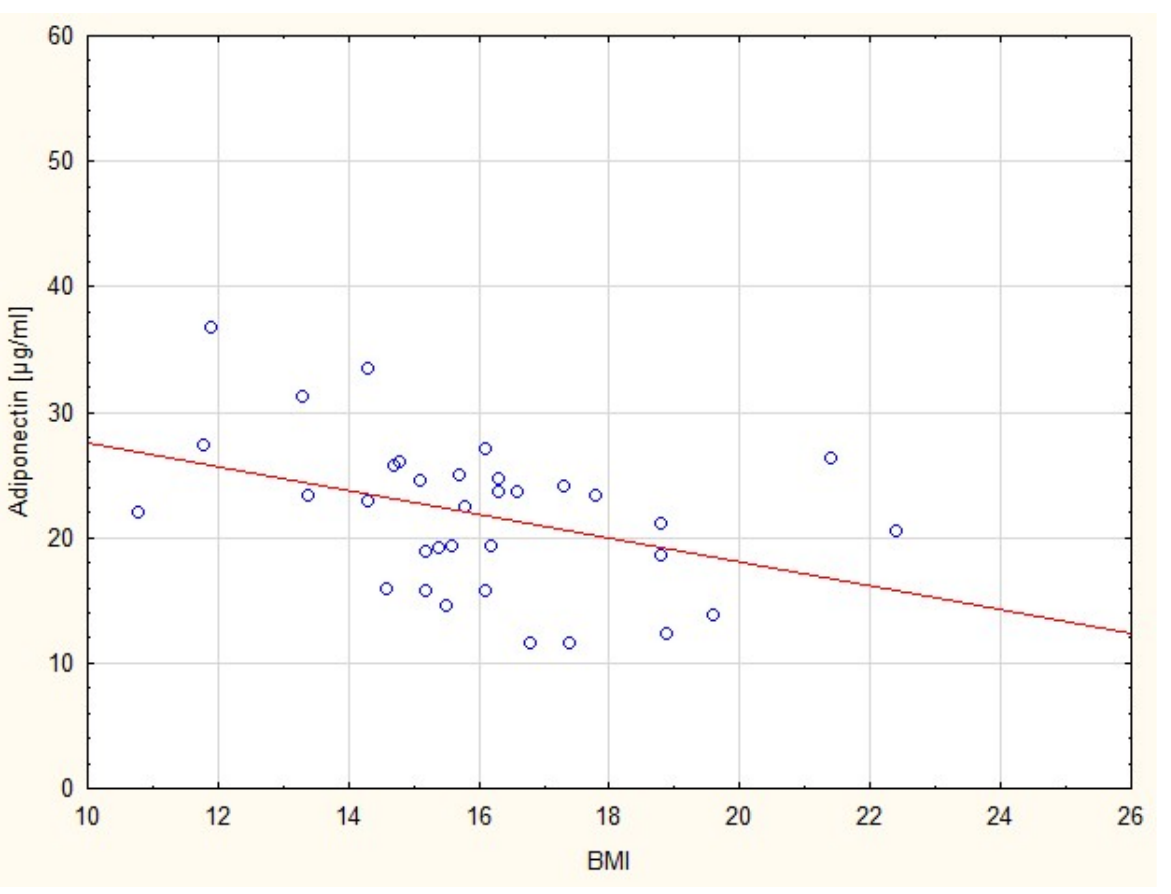
Figure 2. Correlation between serum adiponectin level and BMI in SGA group.